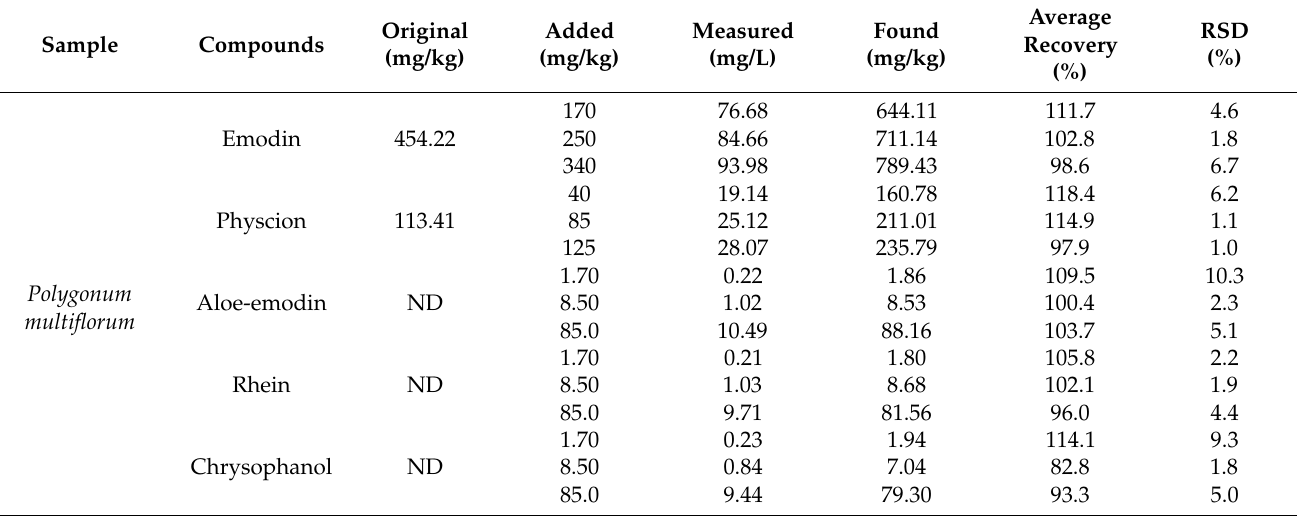
Table 4. The recovery and precision for the determination of the five anthraquinones ( n =